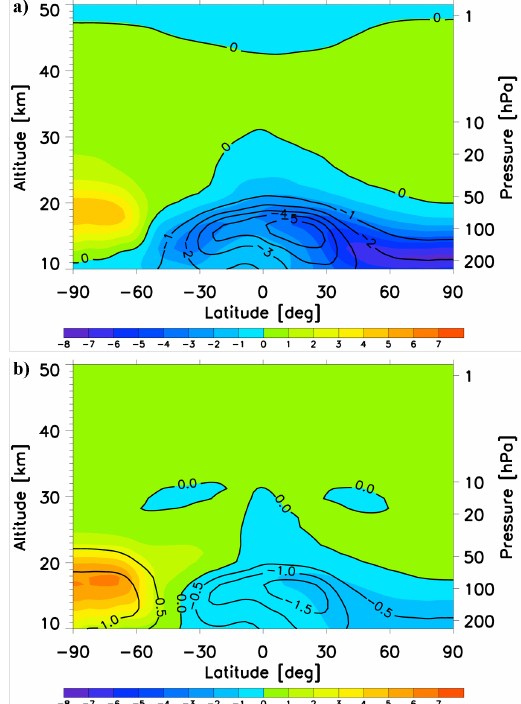
Figure 8. Annually, zonally averaged O 3 concentration changes in units of 10 10 molecules cm - 3 (shown by color) and the relative change in % (shown by contours) in the H 2 -ICE scenarios compared with the BL scenarios as a function of latitude and altitude for (a) A1FI and (b) B1 scenarios.